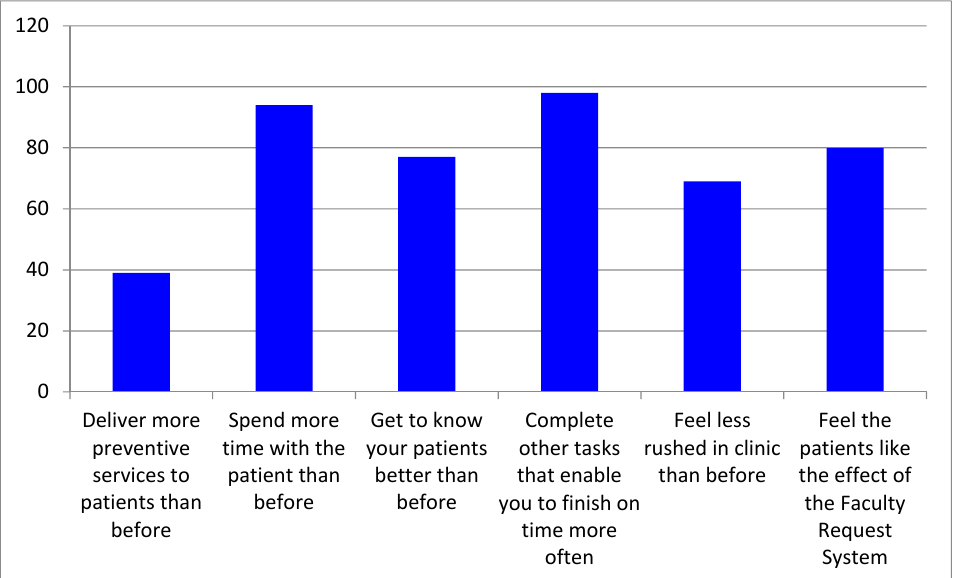
Figure 3. Provider reports of the benefit of implementation of the FRS.